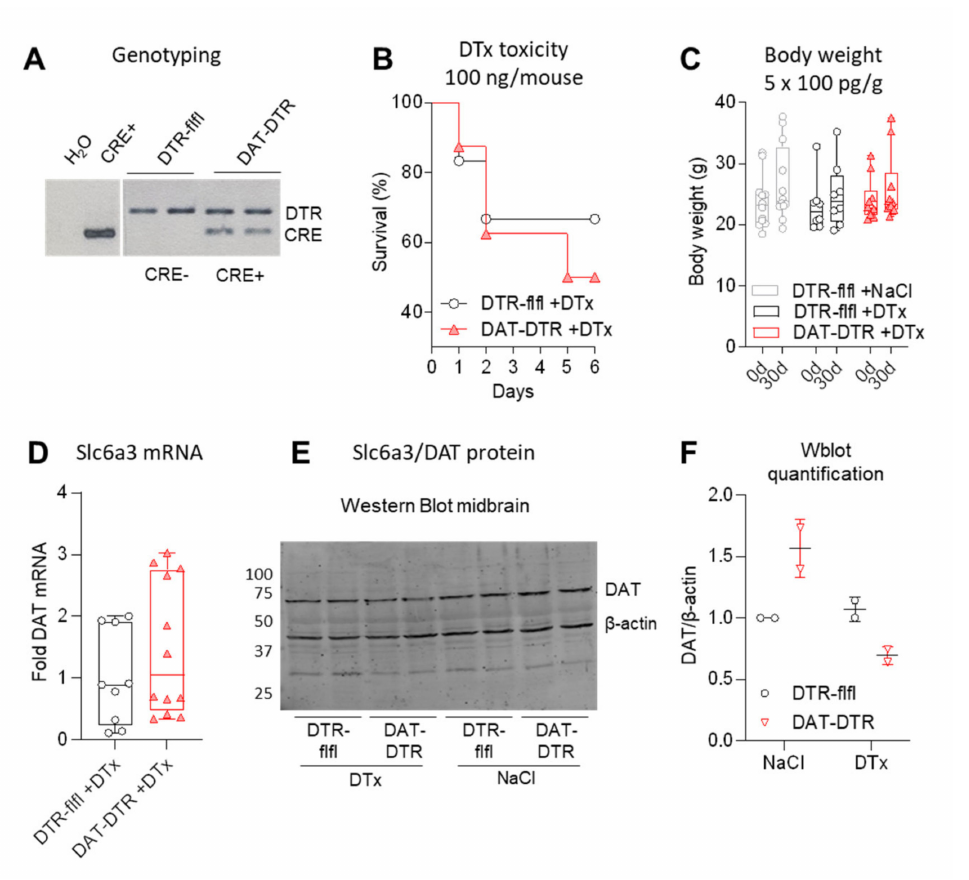
Figure 1. Efficacy of DTx treatment of DAT-DTR mice versus control mice. ( A ) Exemplary agarose gel showing a typical genotyping result. ( B ) Survival curve of mice injected with 100 ng/mouse per dose ( ≈ 4 ng/g) DTx. Details of mice and sample sized per dose in Supplementary Table S1. ( C ) Body weight at baseline and 30 d after treatment with low non-toxic dose of 100 pg/g/d DTx for five consecutive days (cumulative dose 0.5 ng/g). All mice survived. Each scatter is a mouse ( n = 12, 8 and 10). ( D ) Quantitative RT-PCR of DAT/Slc6a3 RNA in the midbrain after 5 × 0.1 ng/g DTx treatment (triplicate samples of n = 3–4 mice). ( E , F ) Western blot analysis and quantification of DAT/Slc6a3 protein in the midbrain after 5 × 0.1 ng/g DTx (example shows n = 2 per group).